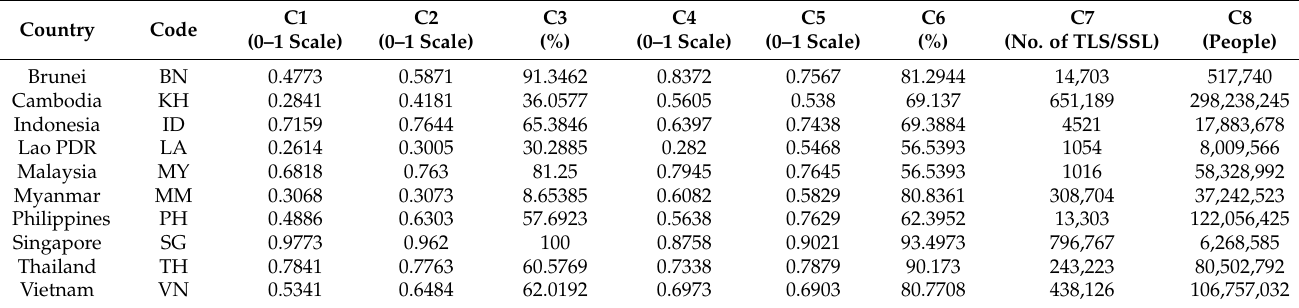
Table 2. Decision